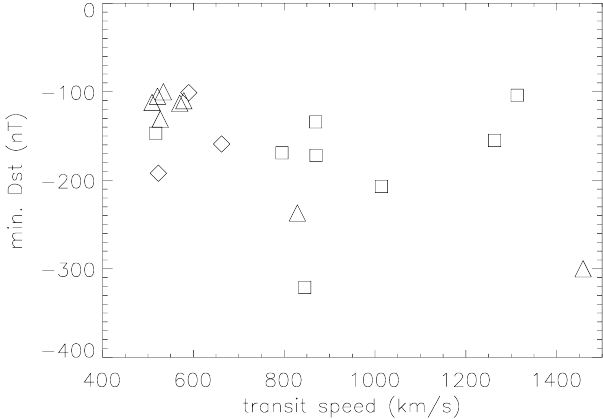
Fig. 1. A scatter plot of average transit speed of interplanetary dis- turbances and minimum D st index of geomagnetic storms (square: magnetic flux rope, triangle: shock, and diamond: